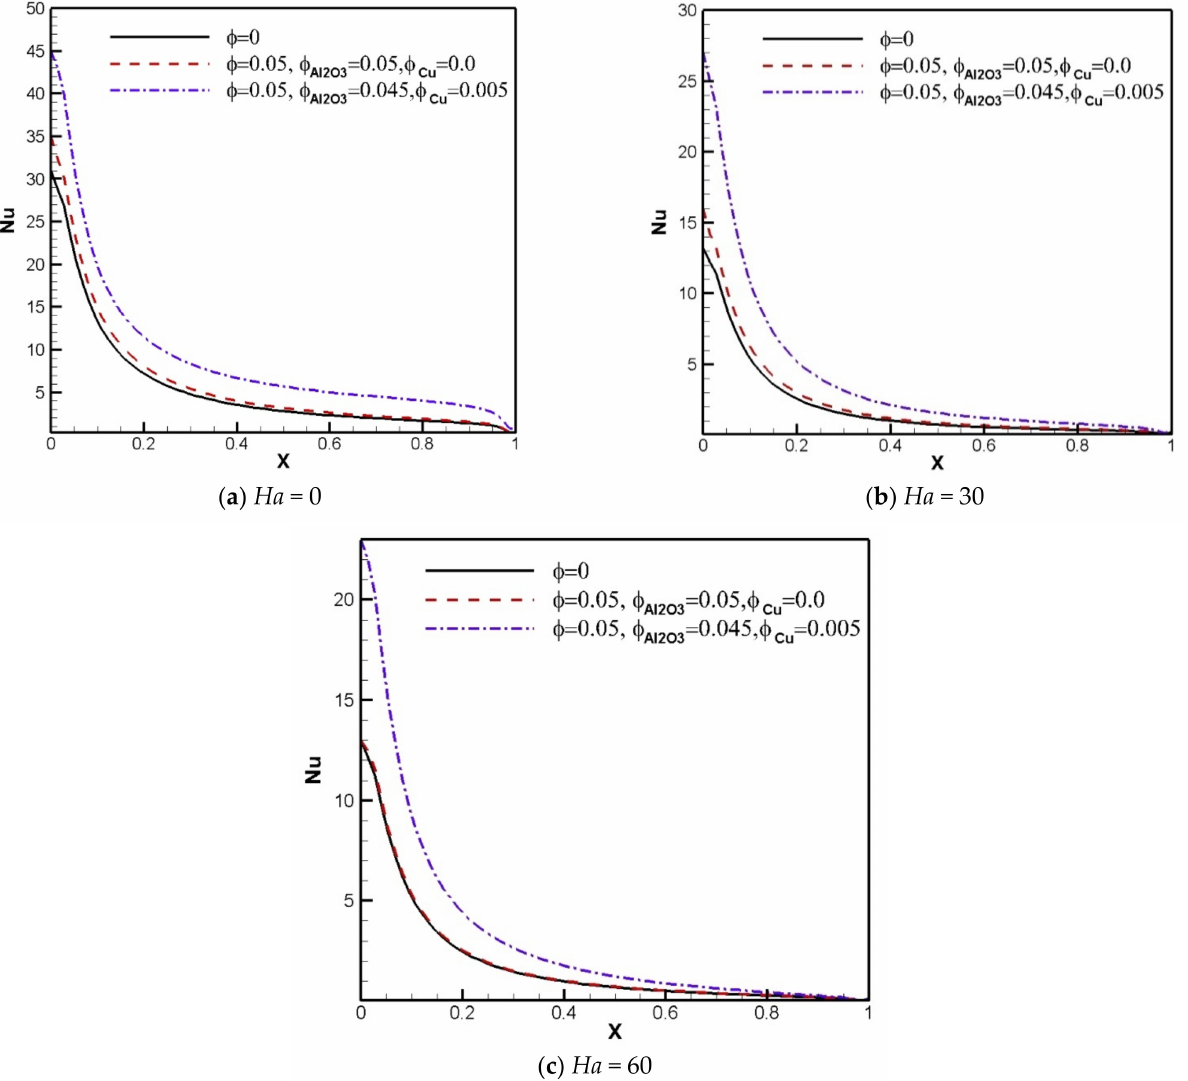
Figure 8. Local Nusselt number profiles versus X -axis for Ri = 0.01 and various Hartmann numbers and solid volume